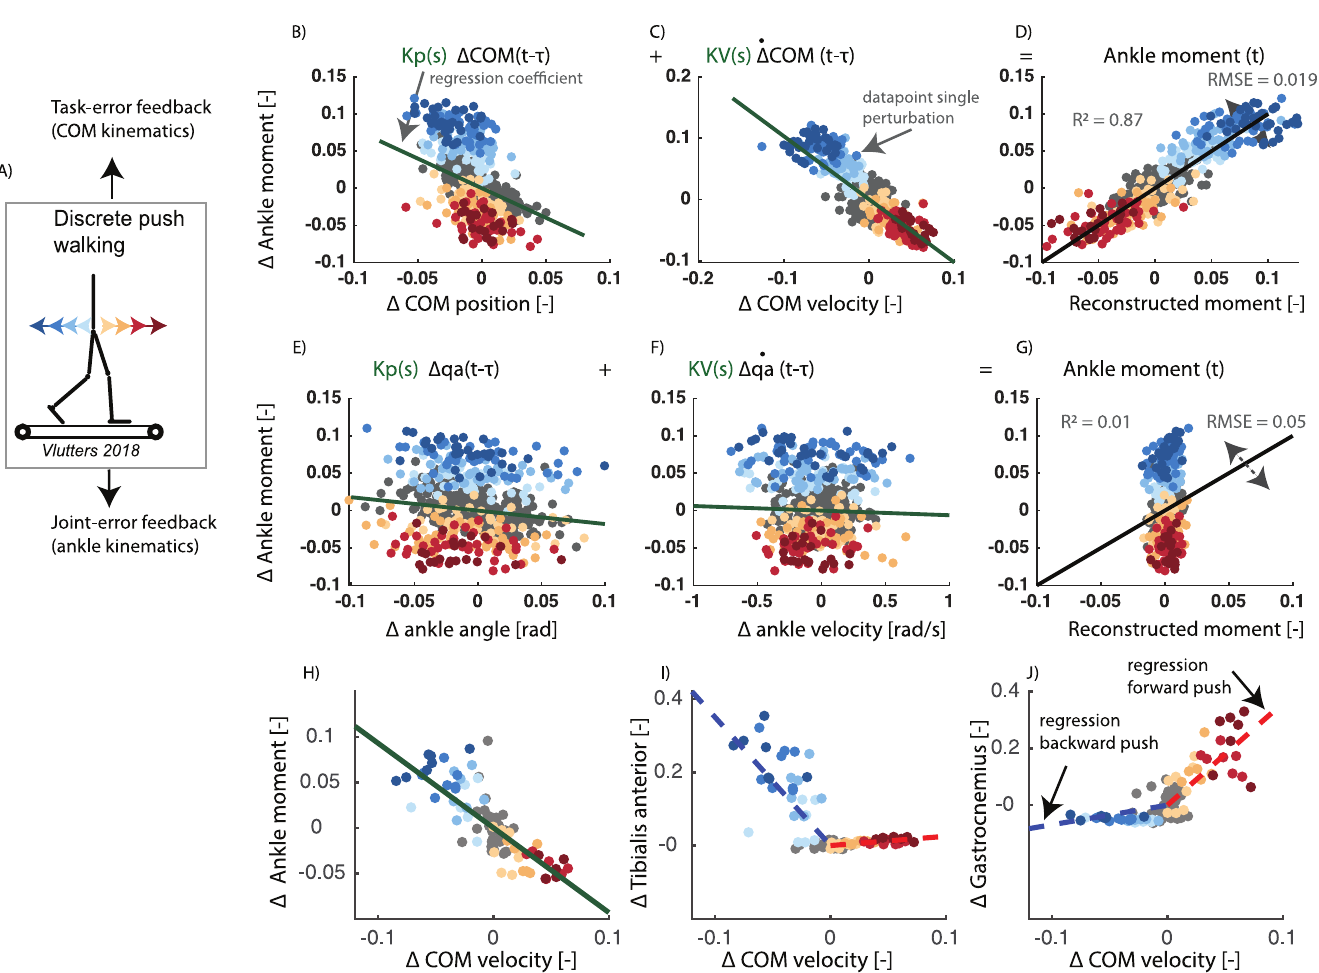
Fig 4. Pelvis push perturbations walking (data from [9]). Reactive ankle moment as a function of the deviation in COM position (A) and velocity (B) from the average reference trajectory during unperturbed walking (gray dots), in response to backward perturbations (blue dots) and forward perturbations (red dots). Least squares regression was used to estimate the position ( K p ) and velocity ( K v ) feedback gains, i.e. slope of green lines (A and B). The uncentered correlation coefficient ( R 2 ) and RMSE is represented in pane D by plotting the measured ankle moment as a function of the reconstructed moment based on COM kinematics. In the same dataset, a similar relation between reactive ankle moment and deviation in ankle joint angle (E) and velocity (F) was evaluated. Ankle moments reconstructed using COM kinematics (D) were more similar to the measured data than ankle moments reconstructed using ankle kinematics (G). There strong correlation between delayed COM velocity and the ankle moment (H) is also reflected in changes in tibialis anterior activity (I) and gastrocnemius activity (J). tibialis anterior activity increases with negative COM velocity (i.e. blue regression line), and gastrocnemius activity increased with positive deviation in COM velocity (i.e. red regression line). Note that a representative example was selected for the muscle activity (H-J) rather than visualizing data pooled over all subjects, since this is only possible for the ankle moment and not for muscle activity due to the limitations related to normalization of electromyography data. This is data of walking at 0.6 m/s with the data pooled over all